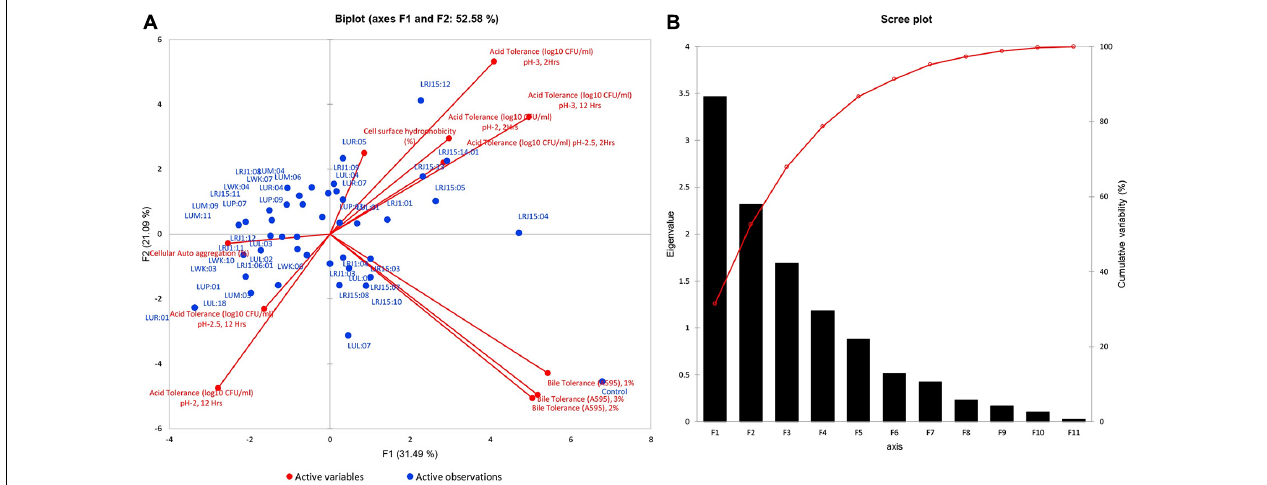
FIGURE 3 | Principal component analysis of the probiotic attributes (acid and bile tolerance at different pH and bile concentration, cell auto-aggregation, cell surface hydrophobicity) of 43 bacterial isolates. (A) Principal component analysis (PCA) biplot projection based on probiotic attributes for the selection of most promising probiotic strain isolated from Traditional fermented beverages lugri. The percentage of variance is explained by the first two factors F1 and F2, reported after each axis. (B) Scree biplot (eigenvalue) of principal components (F1–F11) for the probiotic potential of different isolates from traditional fermented beverage lugri.